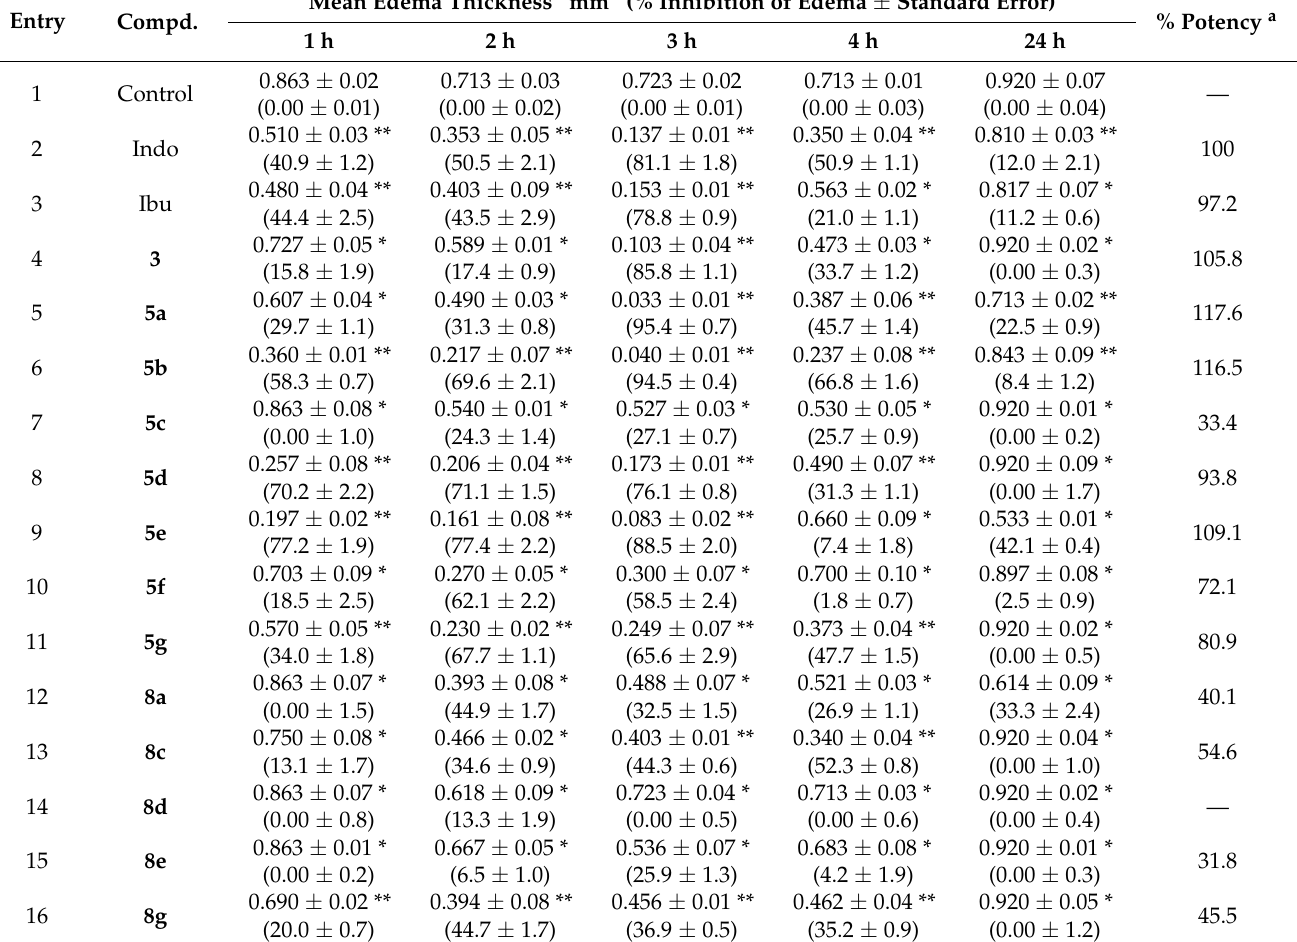
Table 1. Anti-inflammatory properties of the synthesized